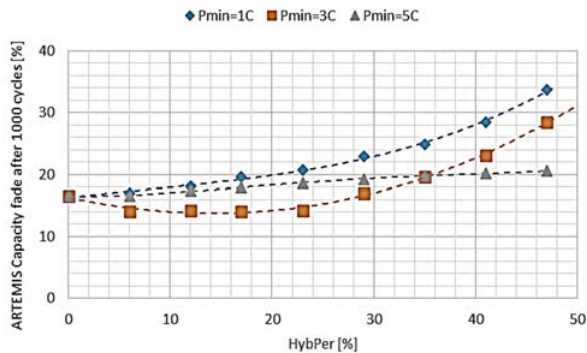
Figure 5. Battery aging for topology 2 as a function of the hybridization percentage for three different values of P MIN .